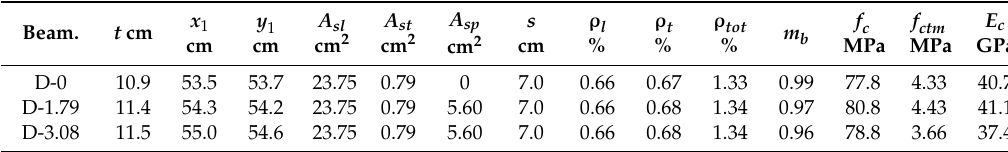
Table 1. Properties of test beams.